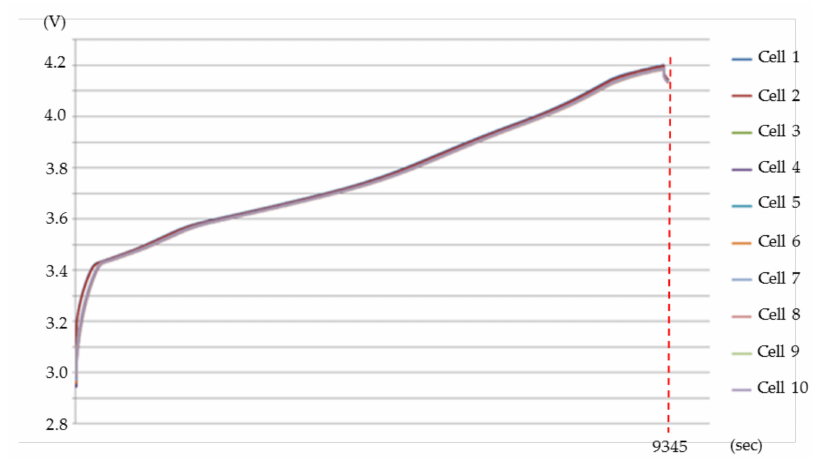
Figure 7. Charging curve measured by voltage